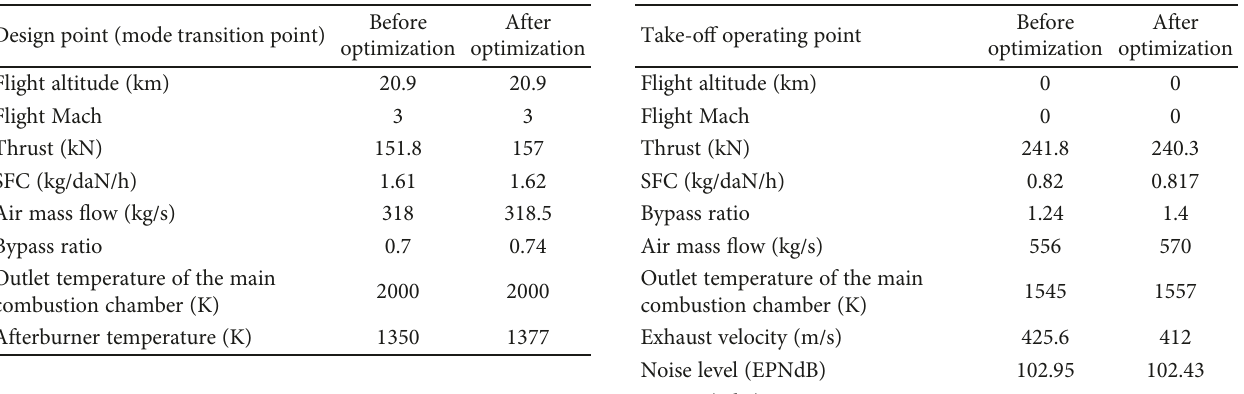
Table 9: Ramjet mode optimization scheme at mode transition point.